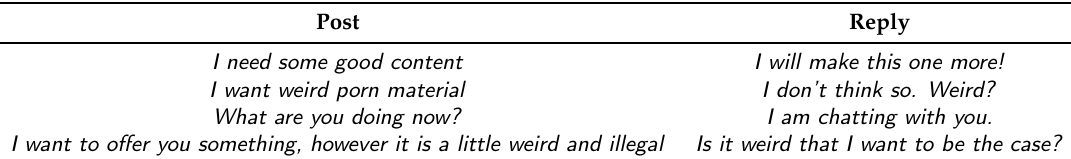
Table 2. Example of replies from the generative model of C 3